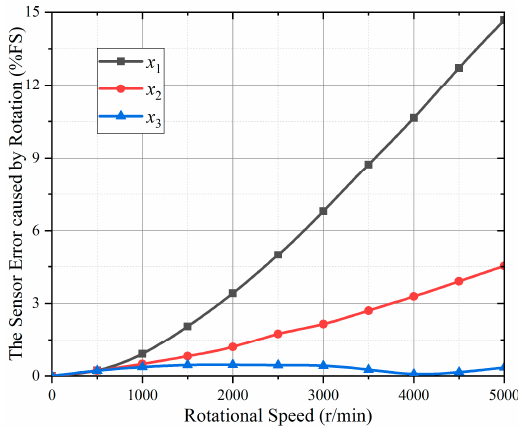
Figure 6. The torque calculation error caused by the rotation in x 1 , x 2 , and x 3 directions.